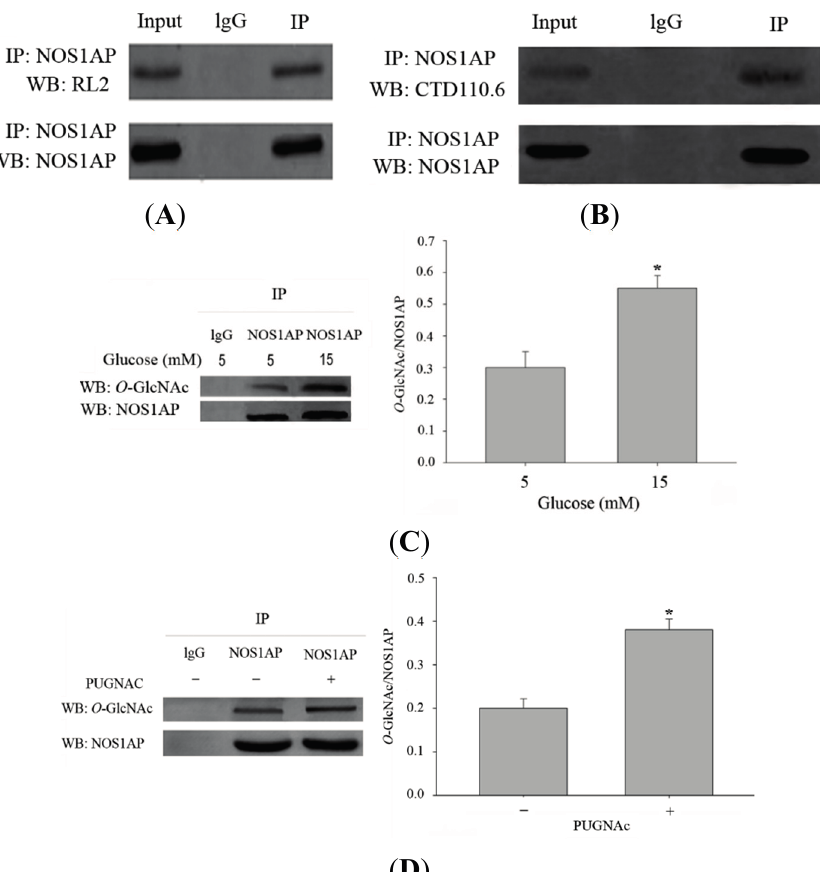
Figure 2. NOS1AP is modified with O -GlcNAc. Biochemical validation of O -GlcNAc on NOS1AP. ( A ) NOS1AP was immunoprecipitated from Human Embryonic Kidney 293 (HEK293) cells and subsequently blotted for O -GlcNAc using the RL2 antibody; ( B ) NOS1AP was immunoprecipitated from PC12 cells and subsequently blotted for O -GlcNAc using the CTD110.6 antibody; ( C ) O -GlcNAc of NOS1AP was enhanced when PC12 cells were cultured in high-glucose medium. The data are mean ± SEM. ( * p < 0.05, significantly distinct from the 5 mM glucose group) and ( D ) O -GlcNAc of NOS1AP from PC12 cells was enhanced when stimulated with PUGNAC. The data are mean ± SEM. ( * p < 0.05, significantly distinct from the group without PUGNAC